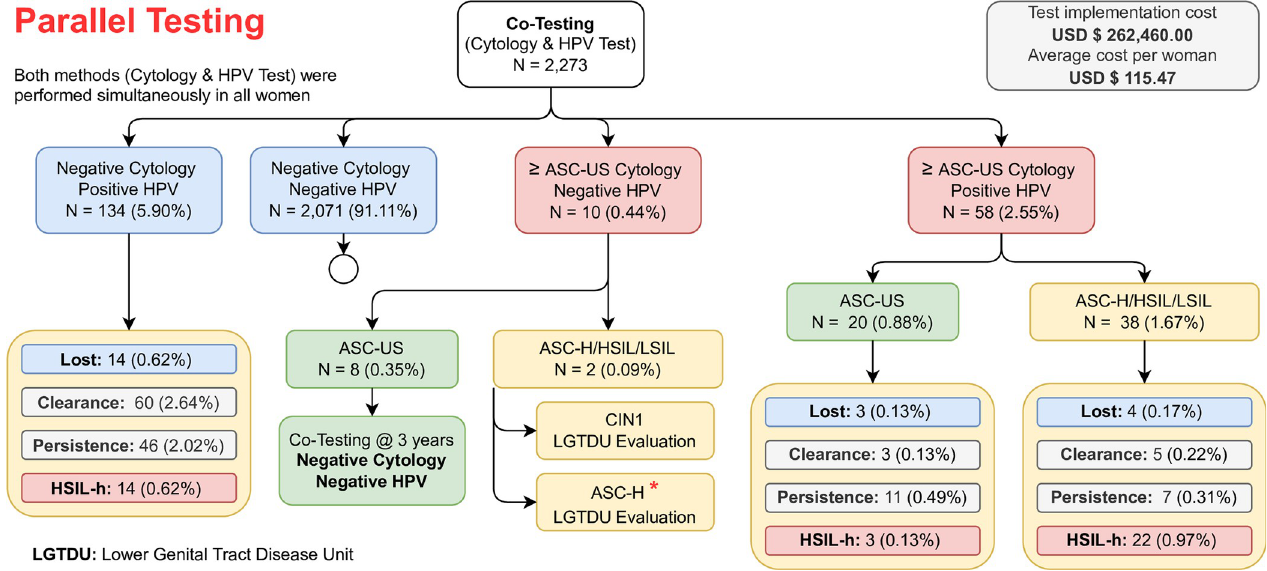
Fig 3. Results of the cervical cancer screening via co-testing algorithm. Atypical Squamous Cells of Undetermined Significance (ASC-US); Cervical Intraepithelial Neoplasia (CIN); Atypical squamous cells (ASC); Human Papillomavirus (HPV); Atypical Glandular Cells (AGC); Adenocarcinoma In Situ